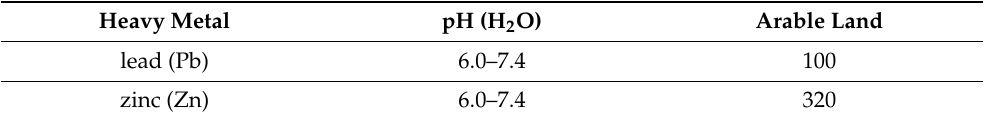
Table 1. Norms for maximum allowable concentrations of heavy metals Pb and Zn in arable land under Regulation № 3 of the 1 August 2008 Bulgarian legislation.